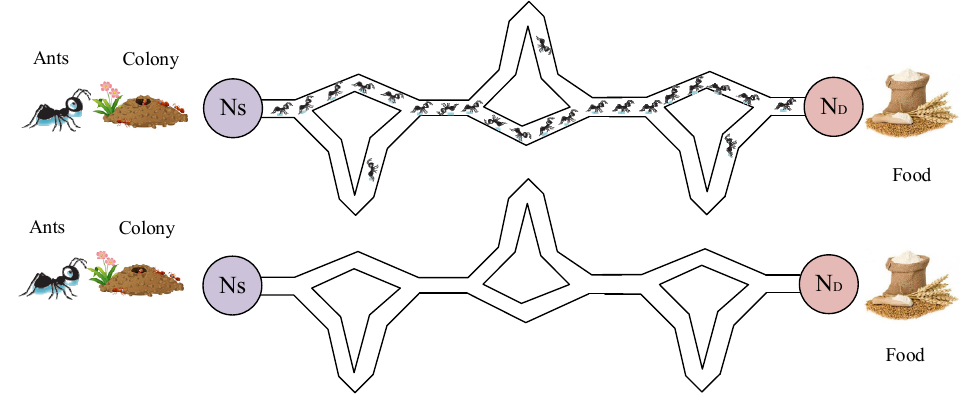
Figure 6. The selection experiment structure of the smallest branches made by a colony of